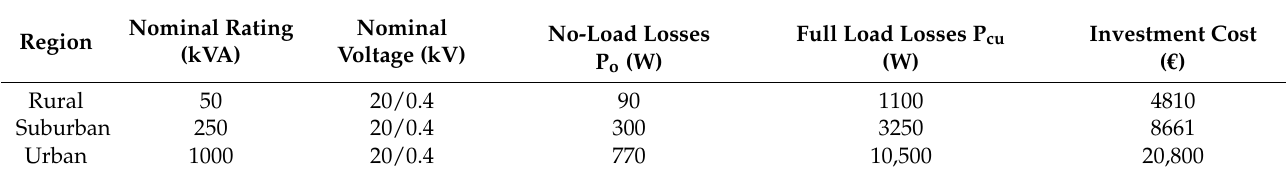
Table 1. Electrical parameters of transformers for three regions [32].